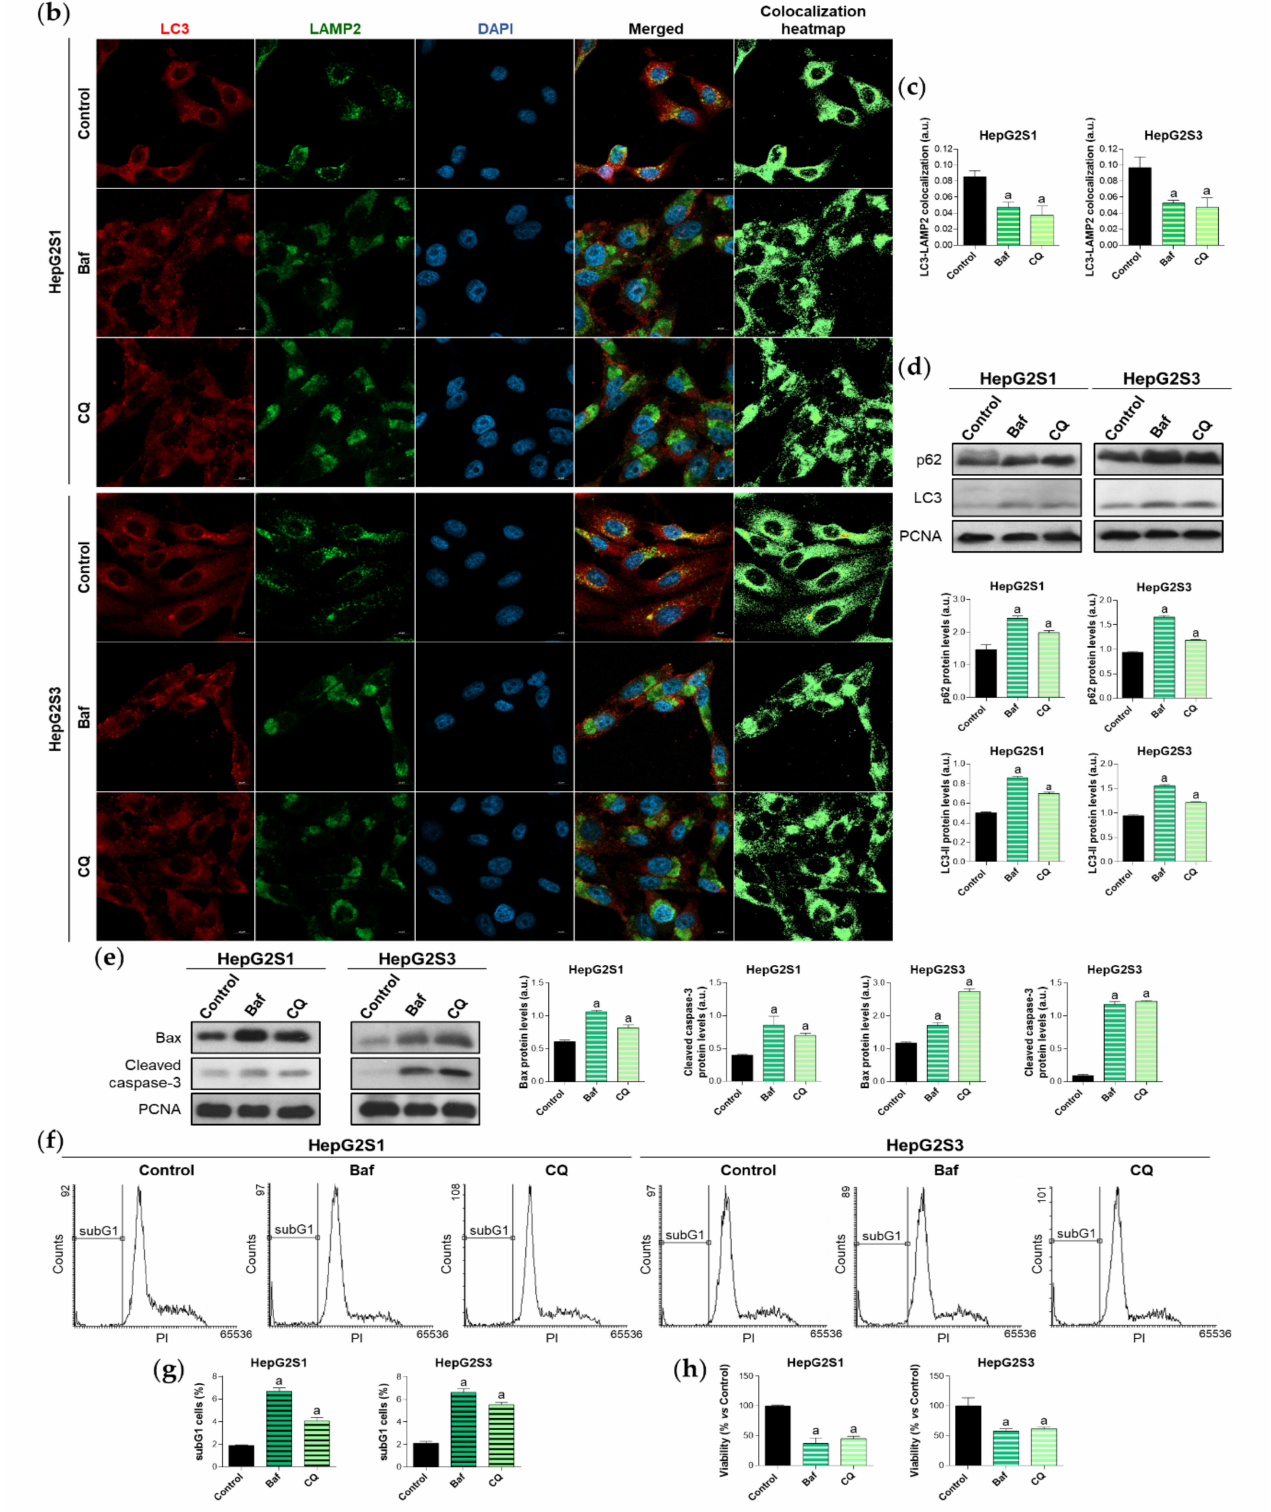
Figure 2. Effect of autophagic flux modulation on basal autophagy, cell death, and viability. Hepatocarcinoma (HCC) cell lines were treated with 100 nM bafilomycin A1 (Baf), 40 µ M chloroquine (CQ) or 200 nM rapamycin (Rapa) for 24 h. ( a ) Fluorescence microscopy images from acridine orange staining. Magnification 40 × , scale bar 25 µ m. Bar graphs representing the quantification of red/green CTCF ratio are also shown; ( b ) Confocal microscopy images from